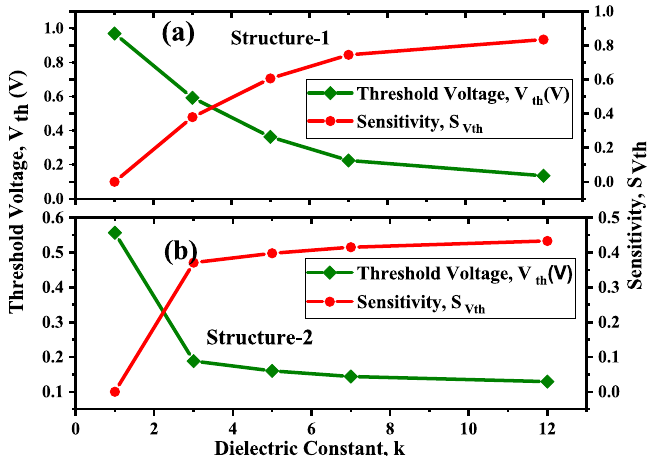
Figure 7. Threshold voltage and Sensitivity w.r.t to dielectric constant ( κ ) of biomolecules with for Device structure-1 and Device structure-2 ( V gs = 1.2 V , κ = 5 , N f = 0 ).